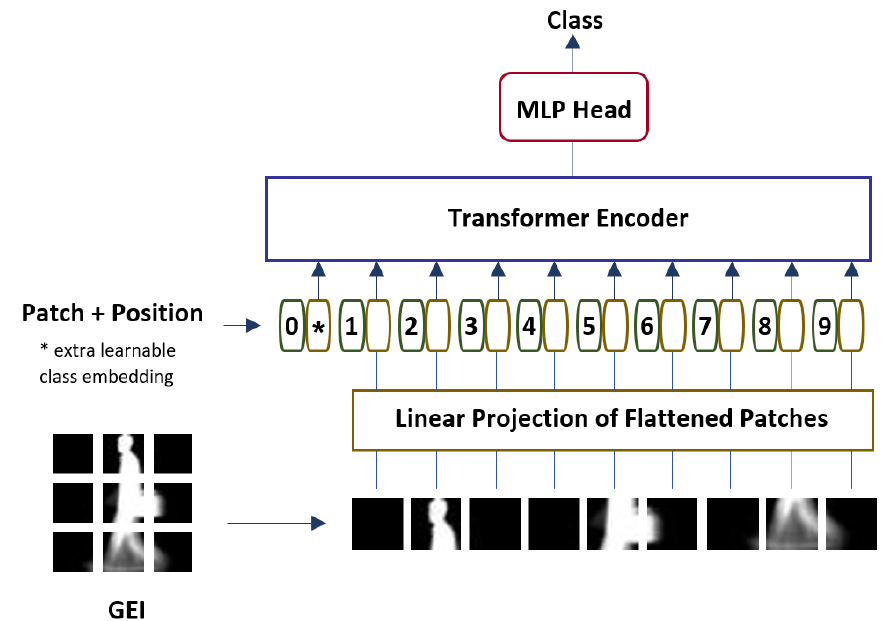
Figure 5. Architecture of the Vision Transformer